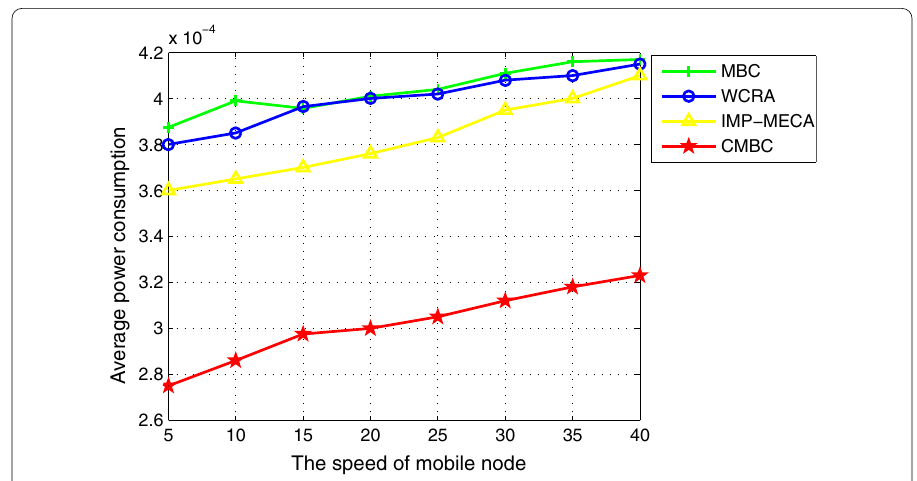
Fig. 9 Results comparison between the speed of mobile node and the average power